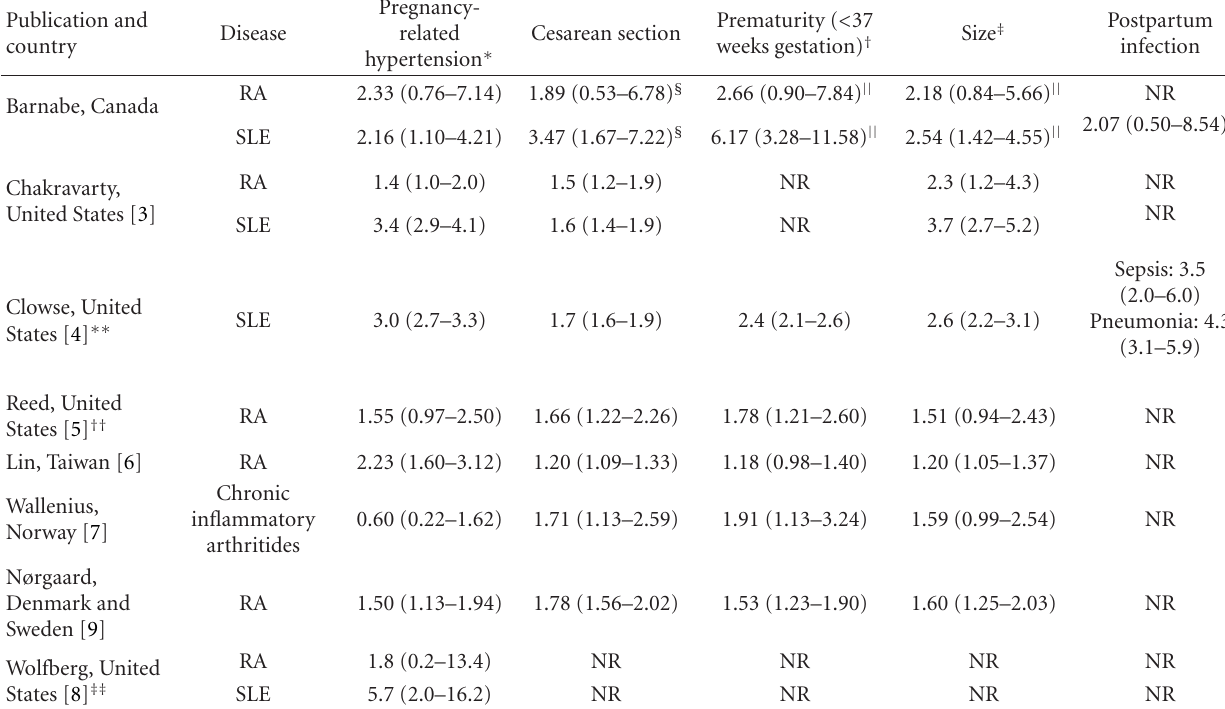
Table 3: Local and worldwide published odds ratios (and 95% confidence intervals) for obstetrical and neonatal